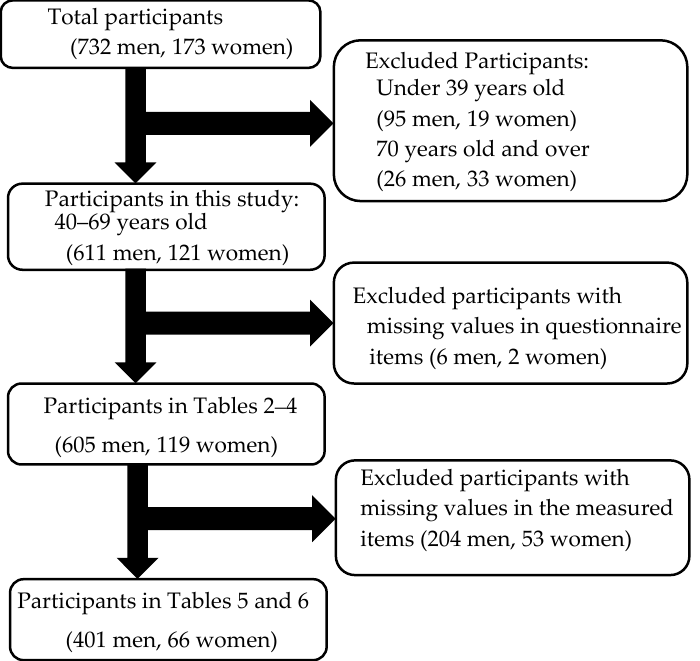
Figure 1. Participant flow diagram.